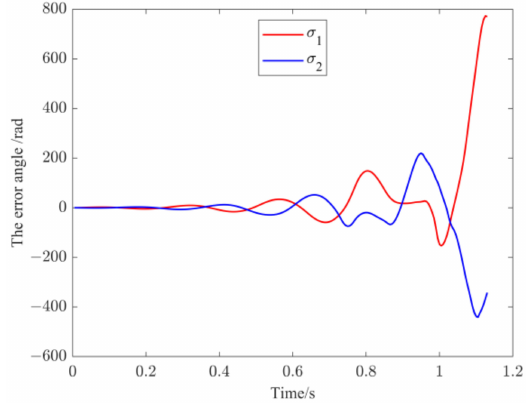
Figure 14. The angle error σ when τ f is off.